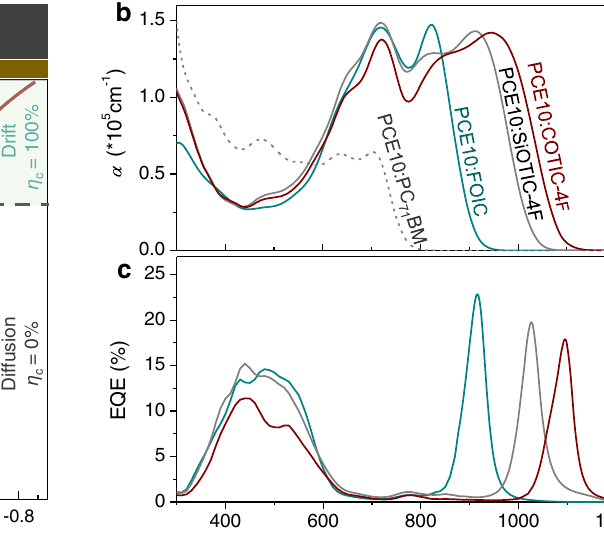
generated chargesis ratheref fi cient. b Absorptioncoef fi cientof the selected near- infraredabsorbingPCE10:NFABHJblend fi lmswiththeabsorptionedgesspanning from 900 to 1100nm. As a reference, PCE10:PC 71 BM fullerene blend is indicated (gray dash line). Note that the absorption coef fi cient here is calculated from the extinction coef fi cient k using the relation α = 4 π k/ λ . c Experimental EQE spectra